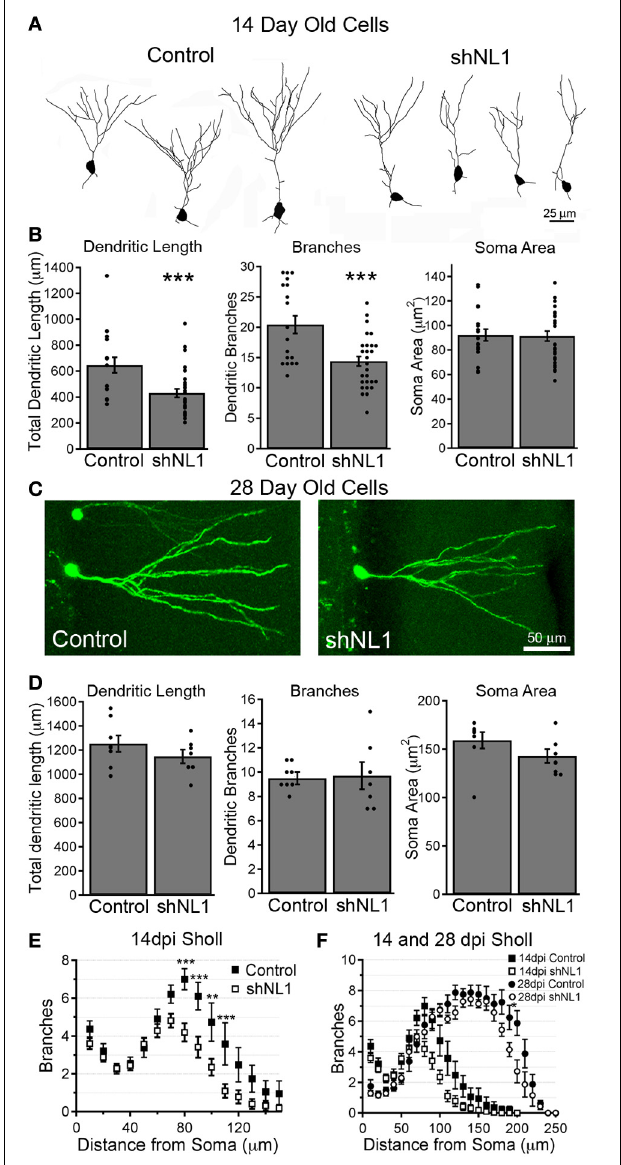
FIGURE 4 | Neuroligin-1 knockdown reduces dendritic complexity during early granule cell maturation. (A) Representative dendrite branching patterns traced from control and neuroligin-1 knockdown (shNL1) newborn granule cells, 14 days post-mitosis. (B) Summary data of average soma cross-sectional area, dendritic branch number, and total dendritic length for 14-day-old control and neuroligin-1 knockdown cells (control, n = 19; shNL1, n = 32 cells; ∗∗∗ p < 0 . 001). (C) Representative newborn control and neuroligin-1 knockdown granule cells at 28 days post-mitosis. (D) Summary data of average soma cross-sectional area, dendritic branch number, and total dendritic length in 28 day-old cells. (control, n = 8; shNL1, n = 7 cells; p > 0 . 1). (E) Sholl analysis of dendritic branching of 14-day-old cells, demonstrating that neuroligin-1 knockdown decreases dendritic tree complexity ( ∗∗ p < 0 . 01; ∗∗∗ p < 0 . 001). (F) Sholl analysis of dendritic branching patterns of 28-day-old adult-born neurons, overlaid onto the Sholl plot for 14-day-old cells ( ∗ p < 0 .